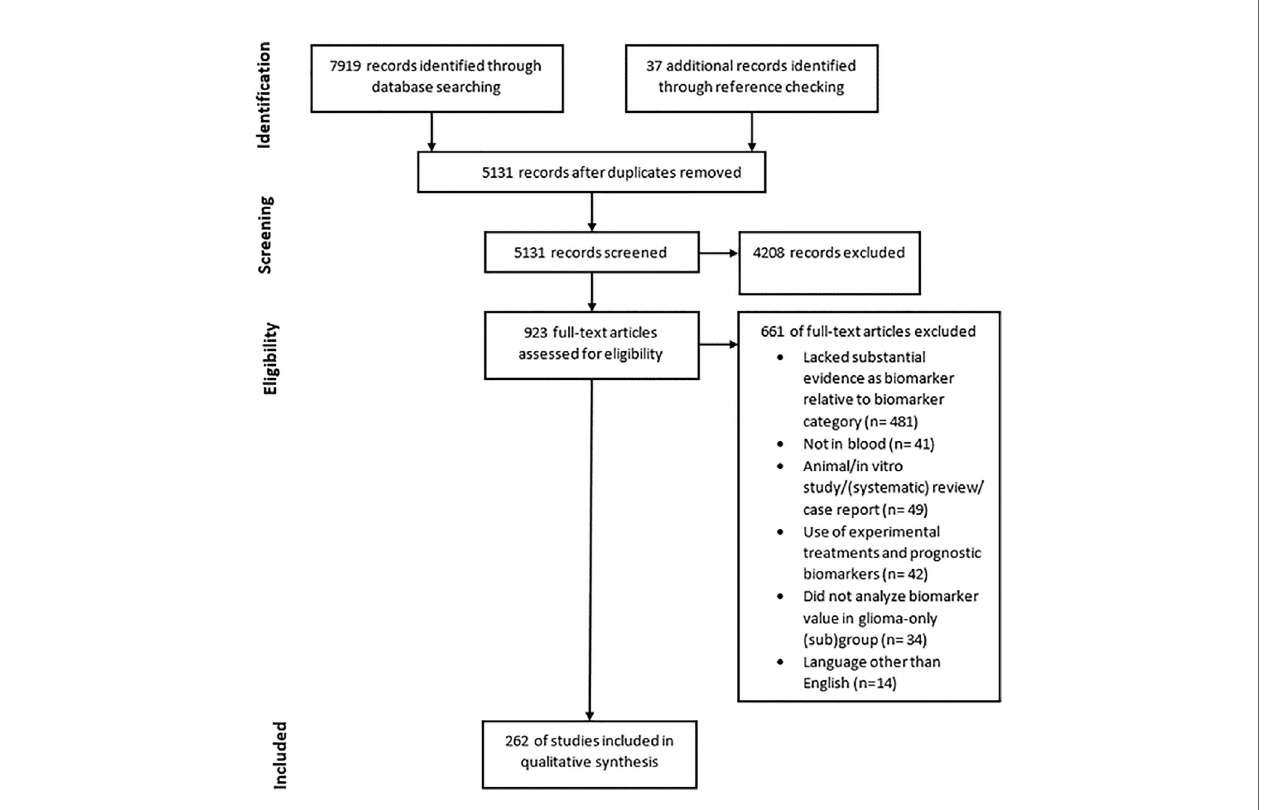
FIGURE 3 | PRISMA diagram showing the amount of records found through database searching and reference checking, the amount of records screened and removed using exclusion criteria and the amount of records included in the fi nal qualitative